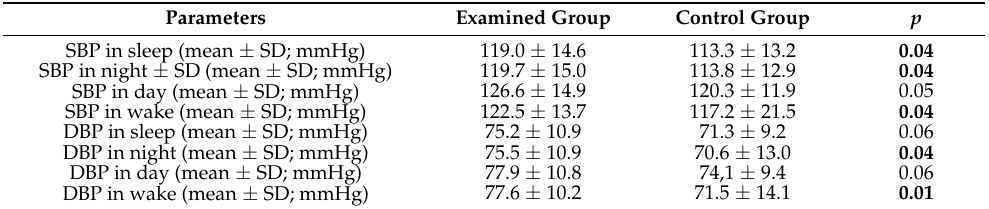
Table 3. Mean values of systolic and diastolic blood pressure in sleep, wake, night and day.